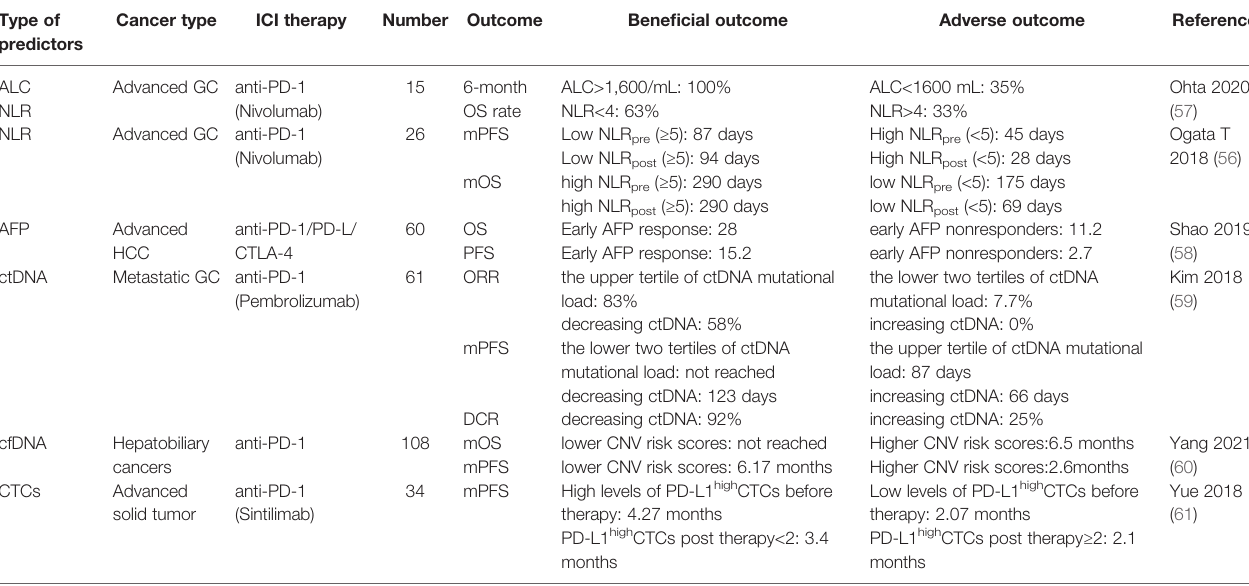
TABLE 3 | Predictive ability of hematological biomarkers for response to ICI therapy for digestive system cancers. Type of